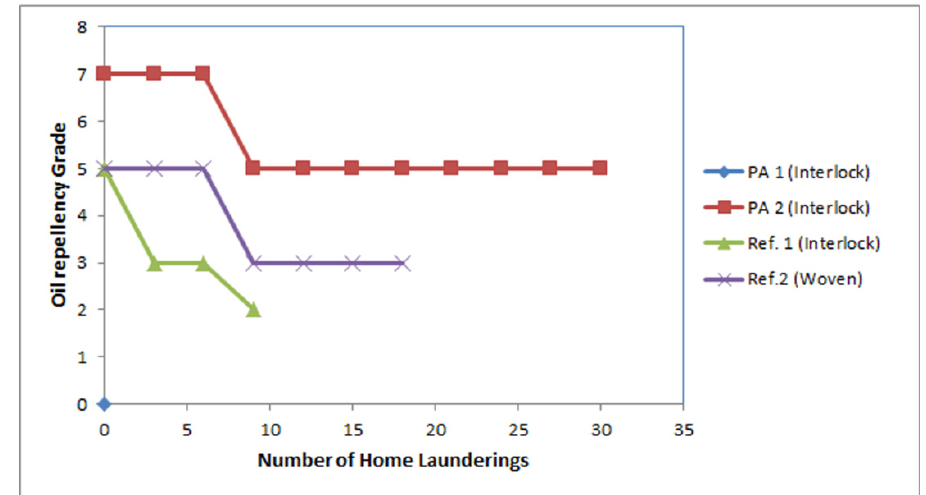
Figure 8. Comparison of oil test for treated fabric with commercial reference samples.